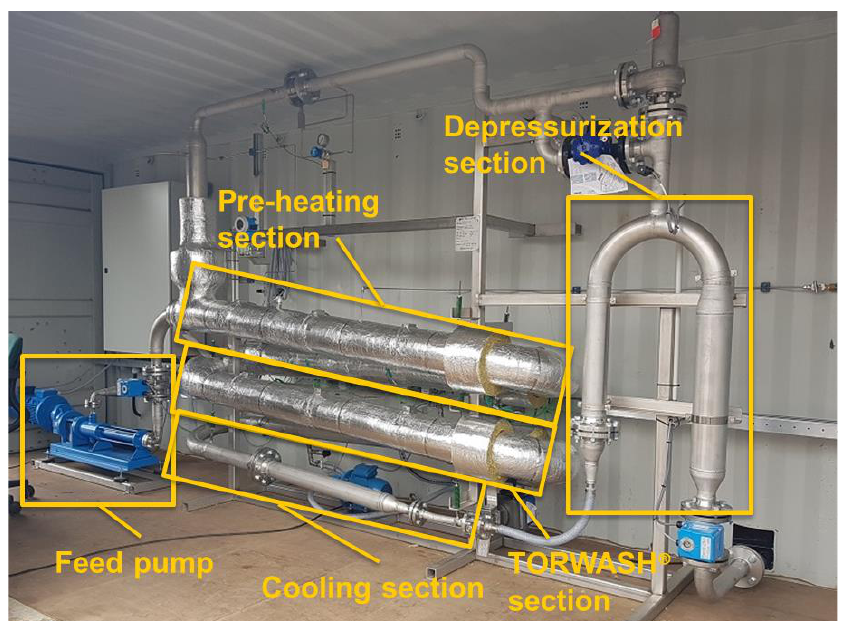
Figure 2. Containerized pilot plant applied for the continuous flow hydrothermal